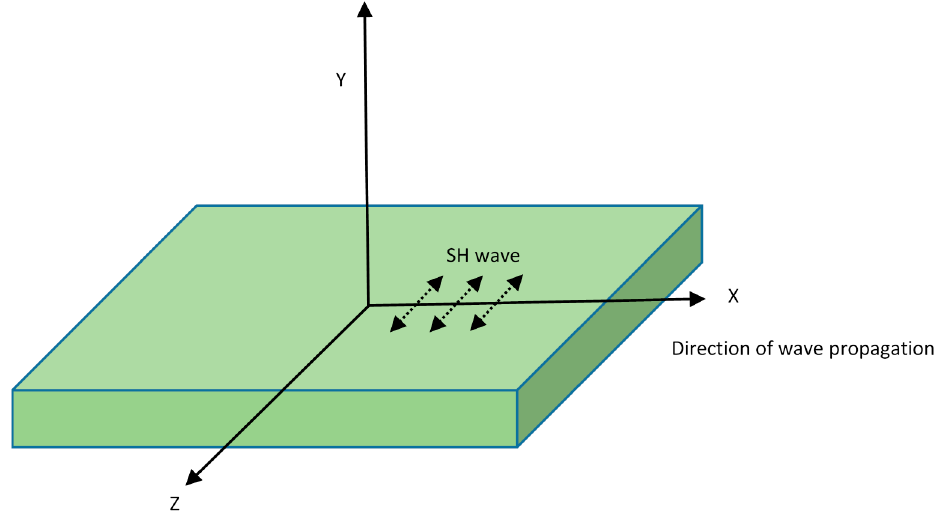
Figure 3. Shear wave propagation (adapted from [40]).